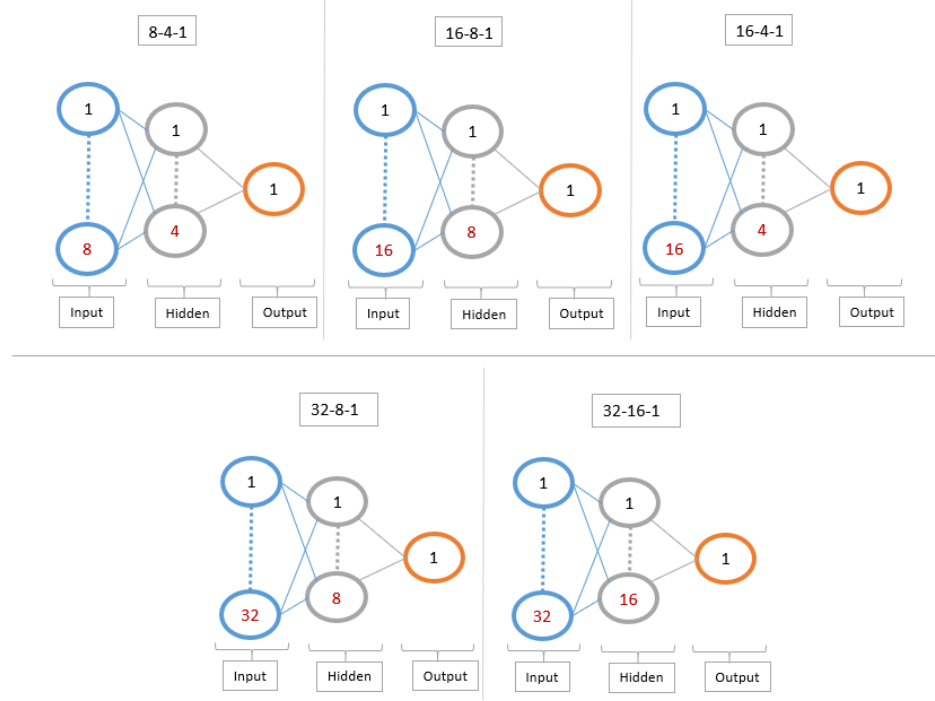
Figure A4. Tests performed on the variation of neurons. Source: Own elaboration.